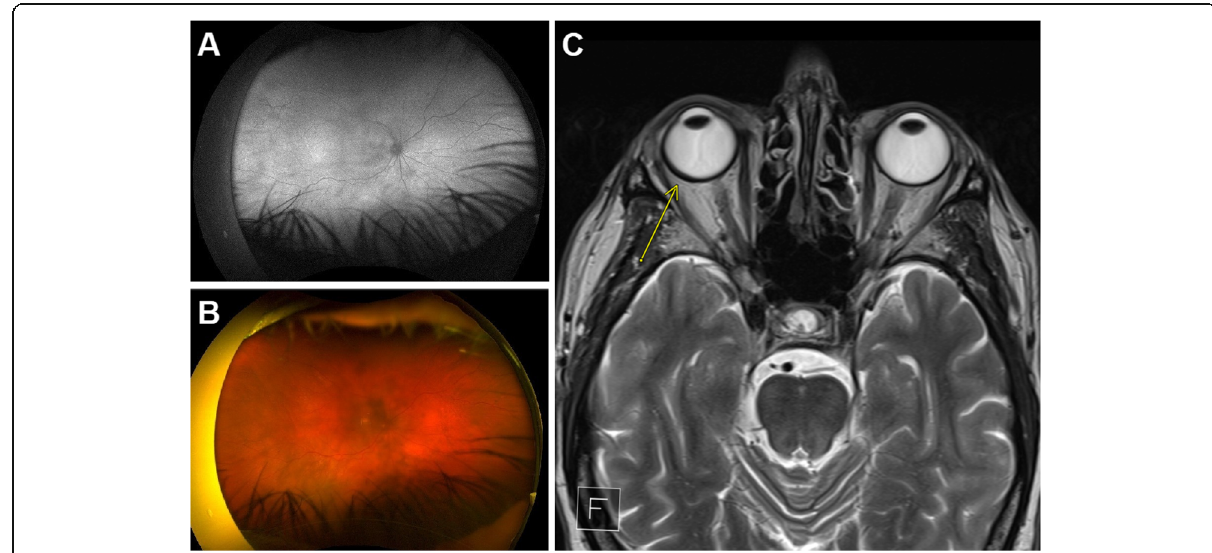
Fig. 2 Imaging prior to treatment initiation. Right eye a ) fundus autofluorescence and b ) pseudocolour images on presentation to ophthalmology oncology clinic; c ) transverse orbital T2-weighted MRI image taken as part of systemic workup, with yellow arrow highlighting asymmetric thickening and enhancement of the wall of the right